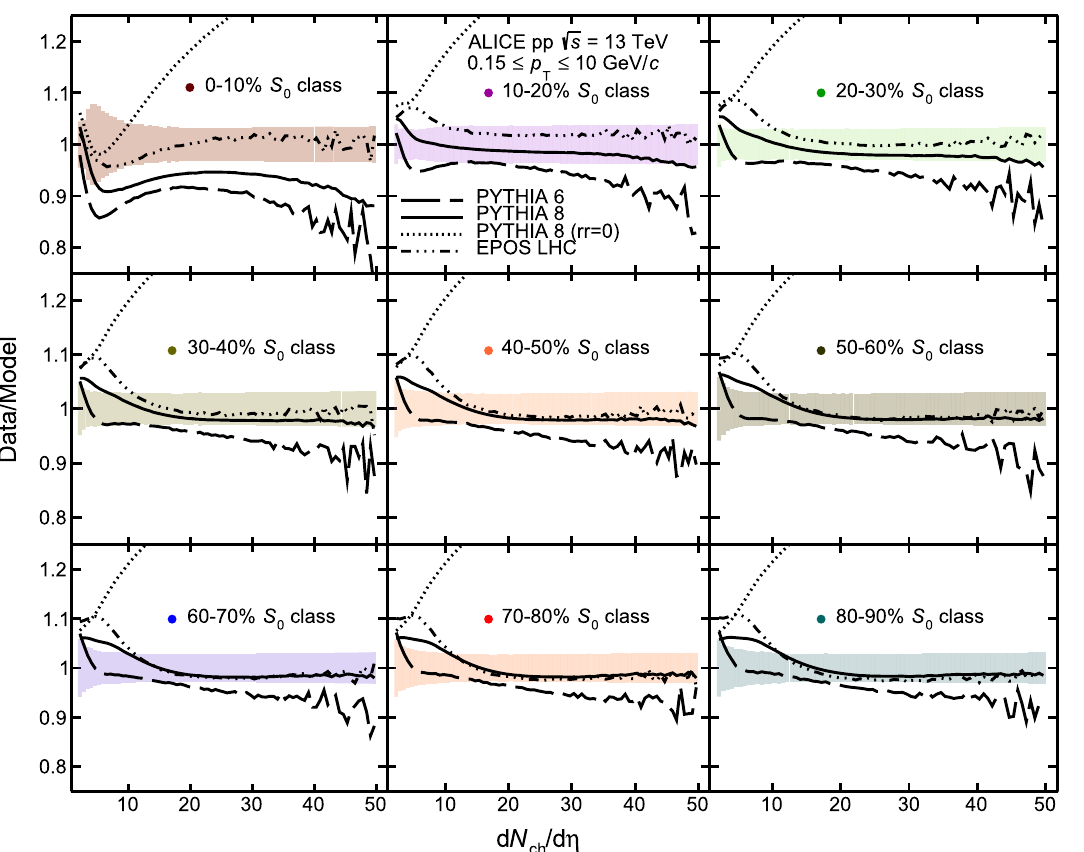
√ s = 13TeV. Results for nine spherocity classes are shown.